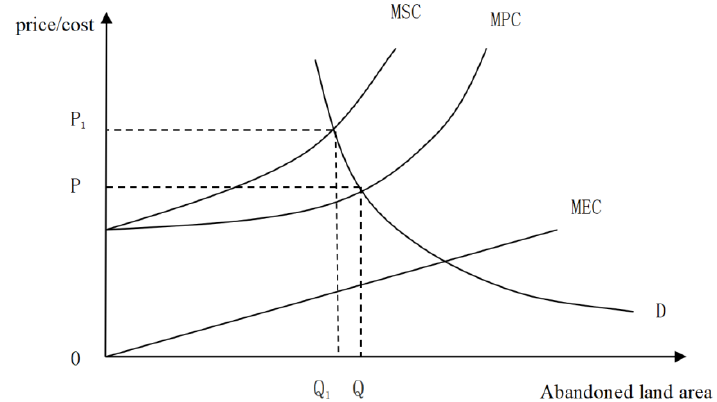
Figure 2. Influence of AB on abandonment.